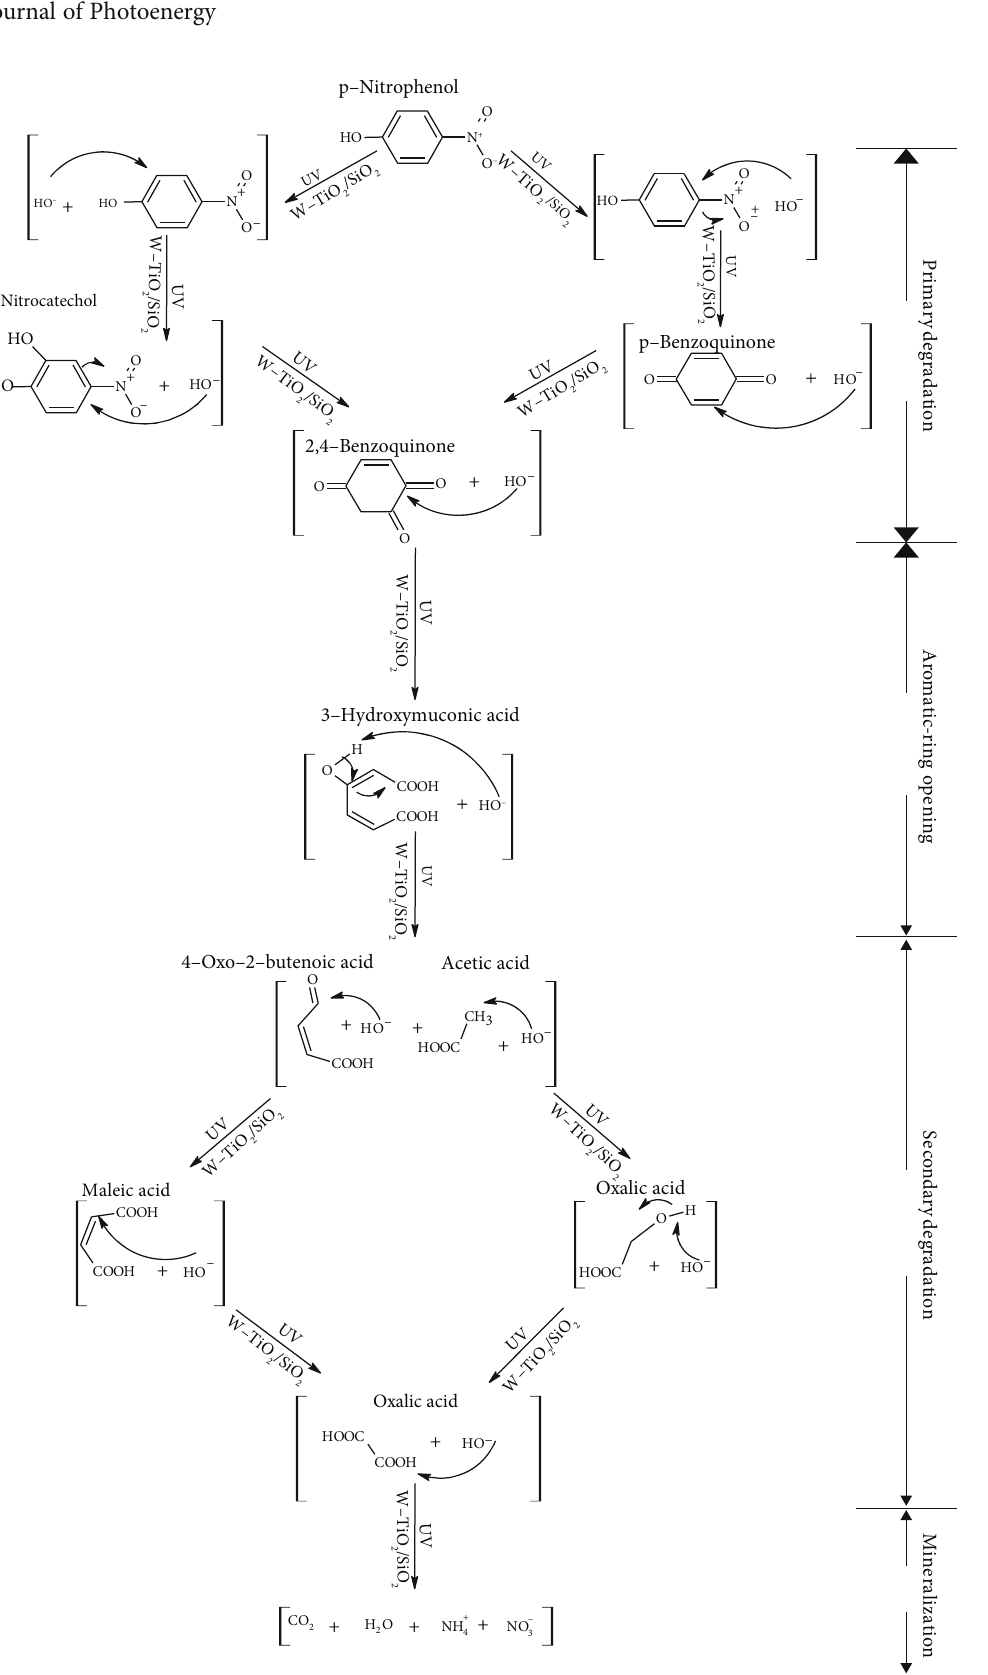
Scheme 2: Pathways of the p -nitrophenol photodegradation reaction under UV irradiation in the presence of the